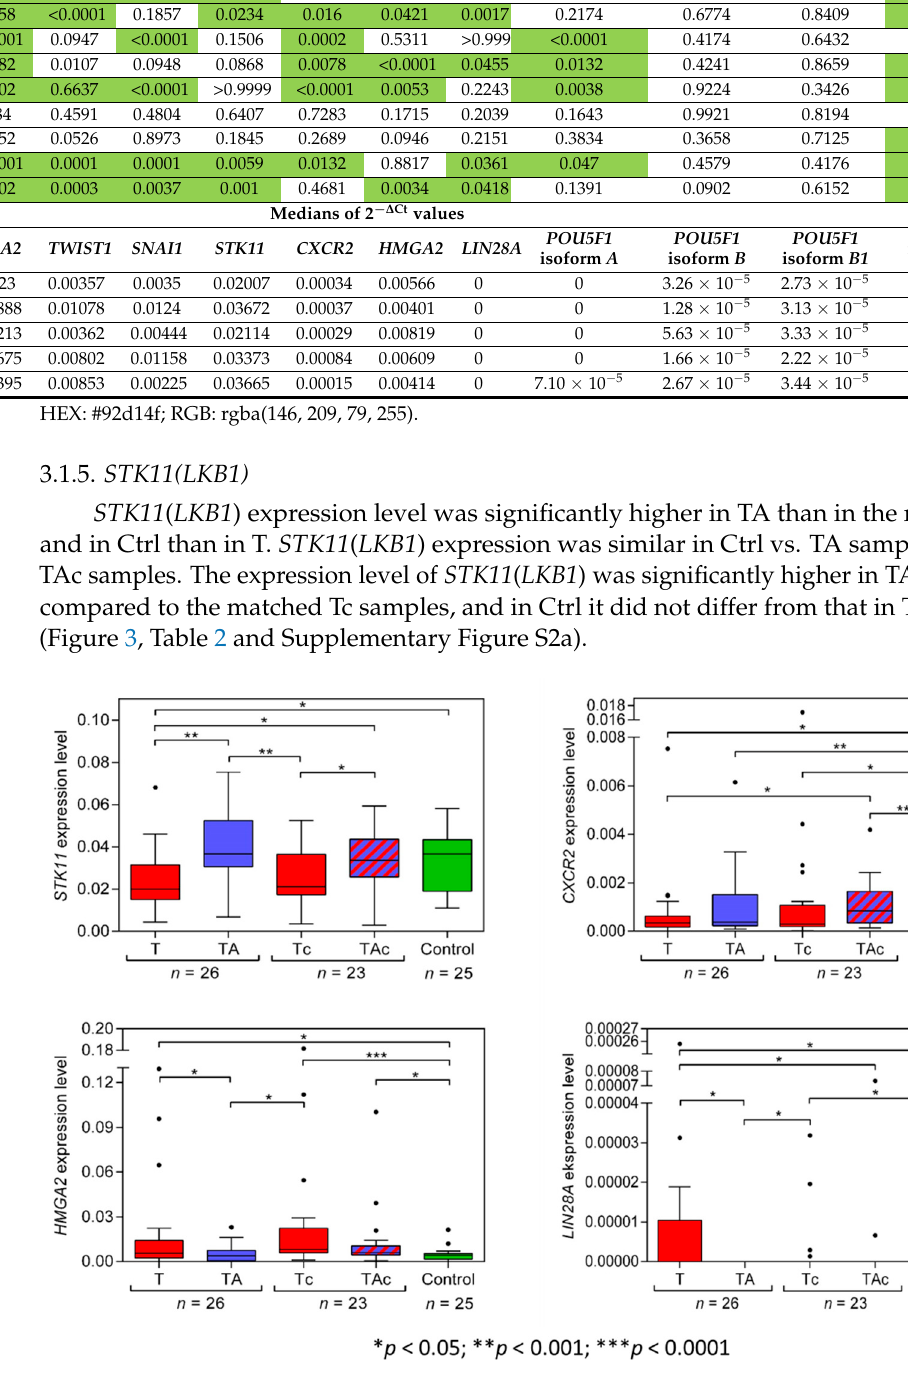
Figure 3. STK11 , CXCR2 , HMGA2 , and LIN28A expression levels in tumors (T, red) and tumor-adjacent tissues without (TA, blue) or with (TAc, blue-dashed) cancer cell content in patients with EC, and in tumor-adjacent tissues in cancer-free patients with leiomyoma (Control, green).